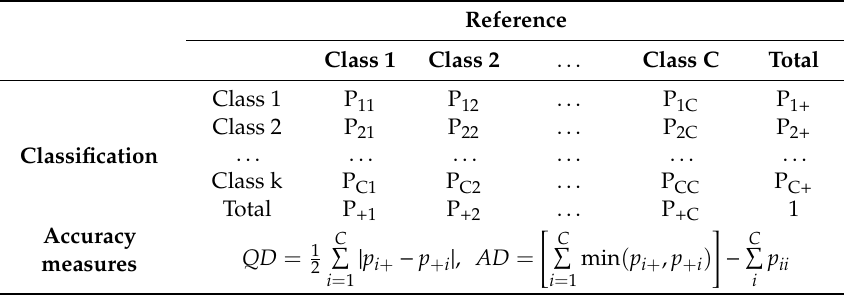
Table 2. Estimated proportion